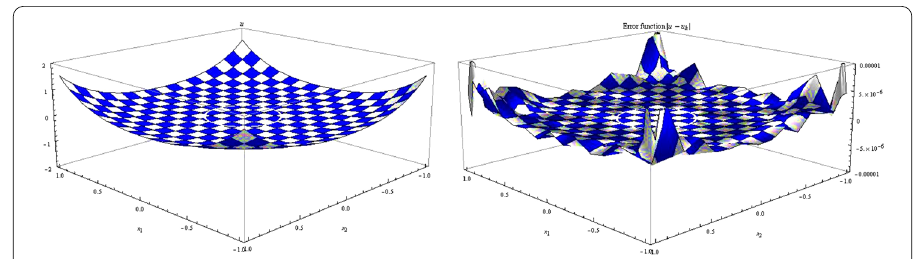
Figure 5 Graphs of the SMRPI solution and the error with h = 1/32 and p = 1.5 for Example 3